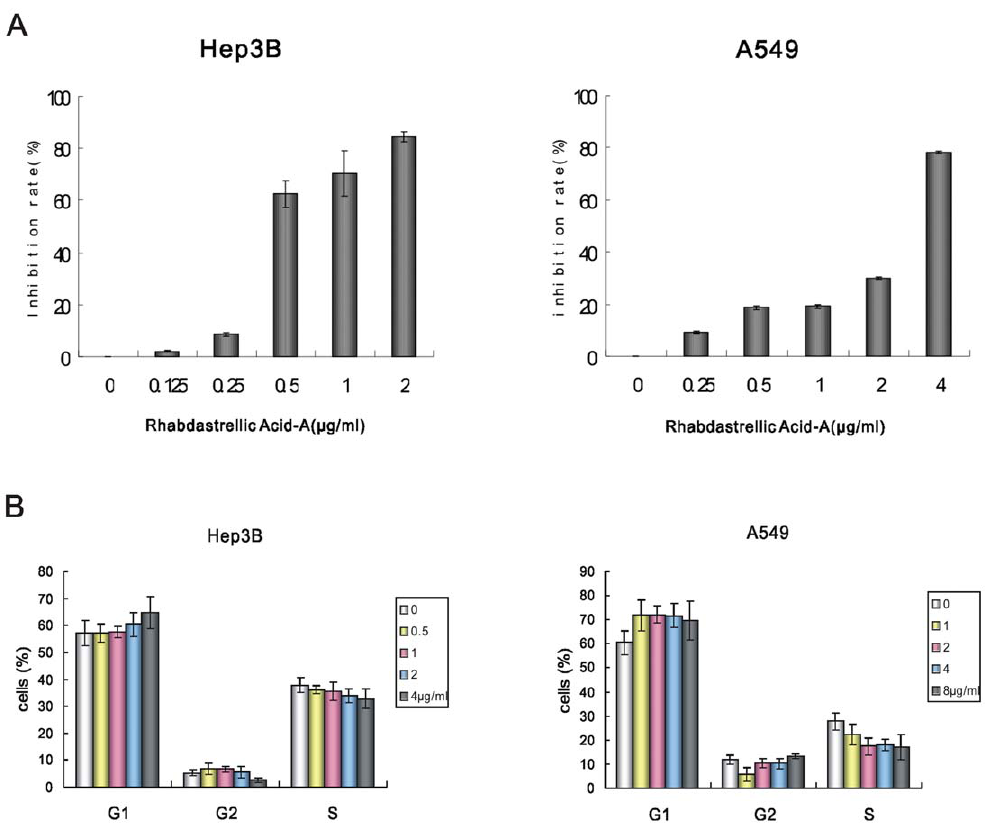
Figure 2. Growth inhibition of Rhabdastrellic acid-A on Hep3B and A549 cells. A. Cancer cells were plated at the density of 8000 cells/well in a 96-well plate. The stock of Rhabdastrellic acid-A was added to wells. Cells were cultured for 3 days. MTT assay was conducted. B. Hep3B and A549 cells were treated with indicated concentrations of Rhabdastrellic acid-A for 48 h and analyzed for the DNA content by flow cytometry. The results were representative of 3